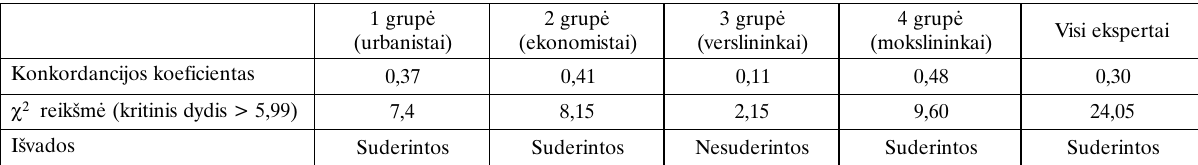
Table 3. Experts’ compatibility